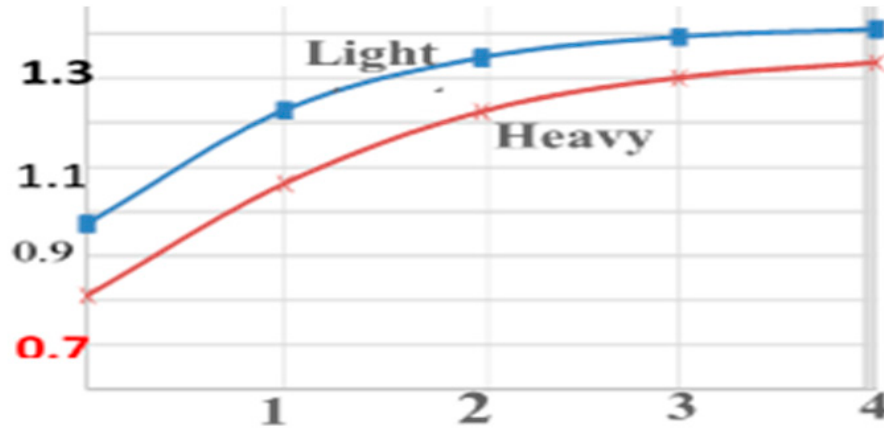
Figure 1. Structure type impacts the design cooling load versus cooling time, in days (From Fadiejev et al. [34]).